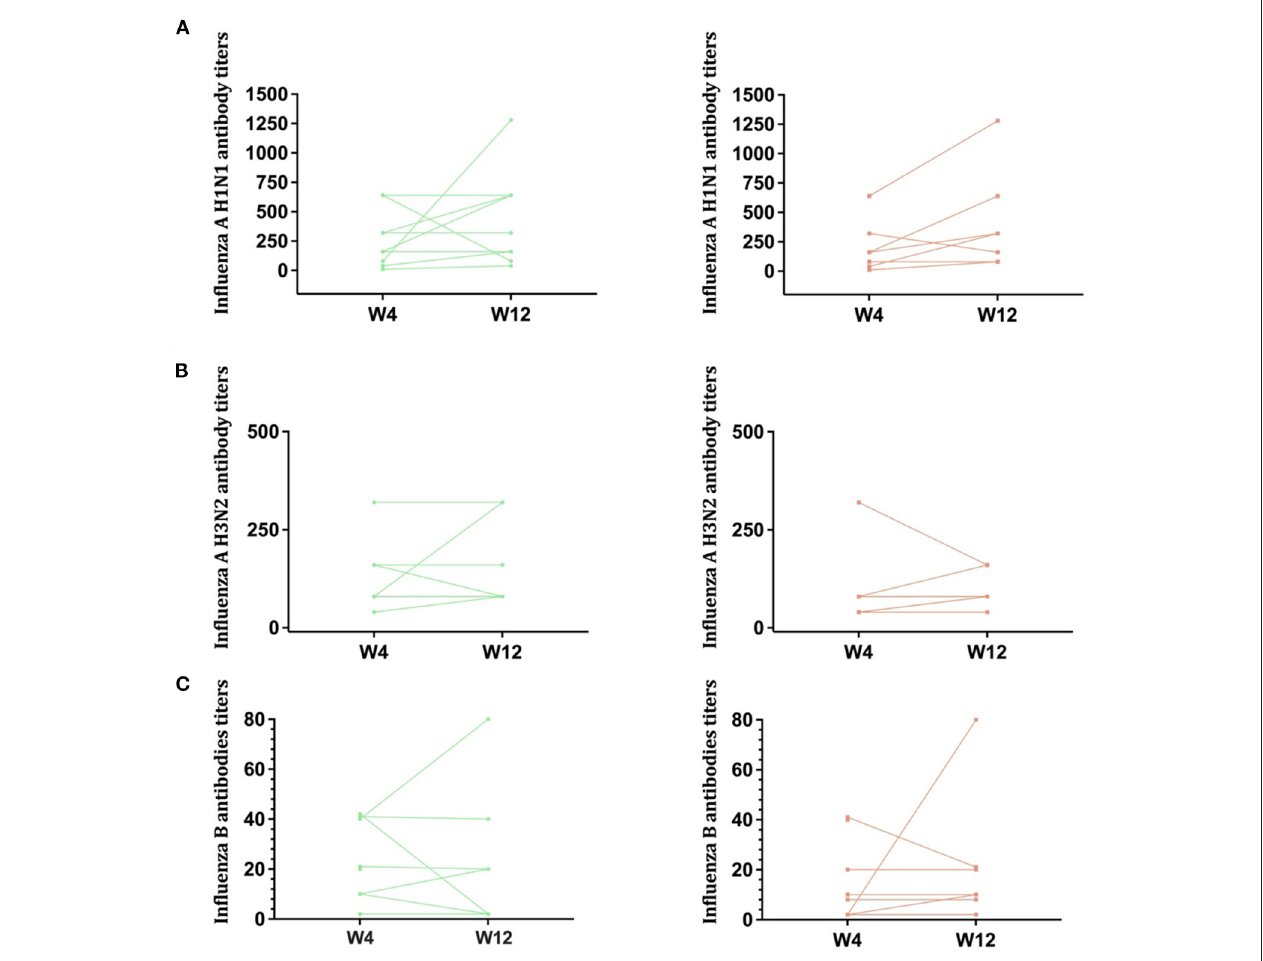
FIGURE 1 | Antibody titers against influenza. Antibody titers against Influenza A H1N1 (A) , Influenza A H3N2 (B) , and Influenza B (C) are shown in this figure, according to randomization group (Left: placebo, Right: intervention arm). Lines represent individual trajectories.